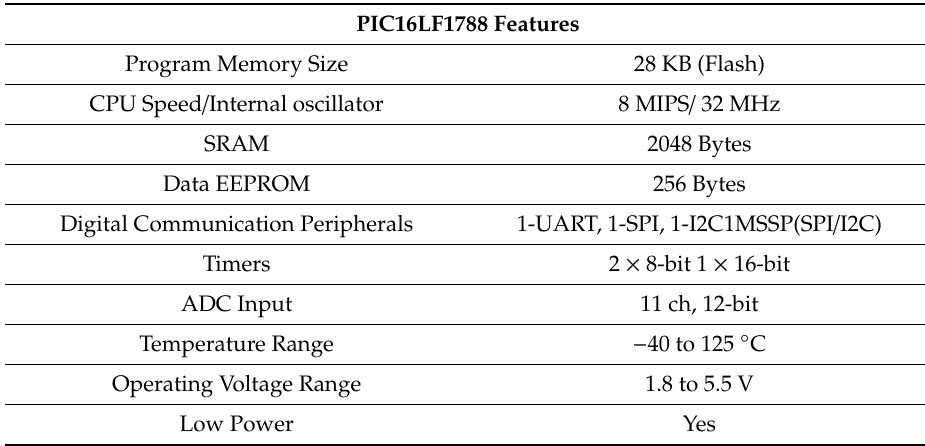
Table 3. The PIC16LF1788